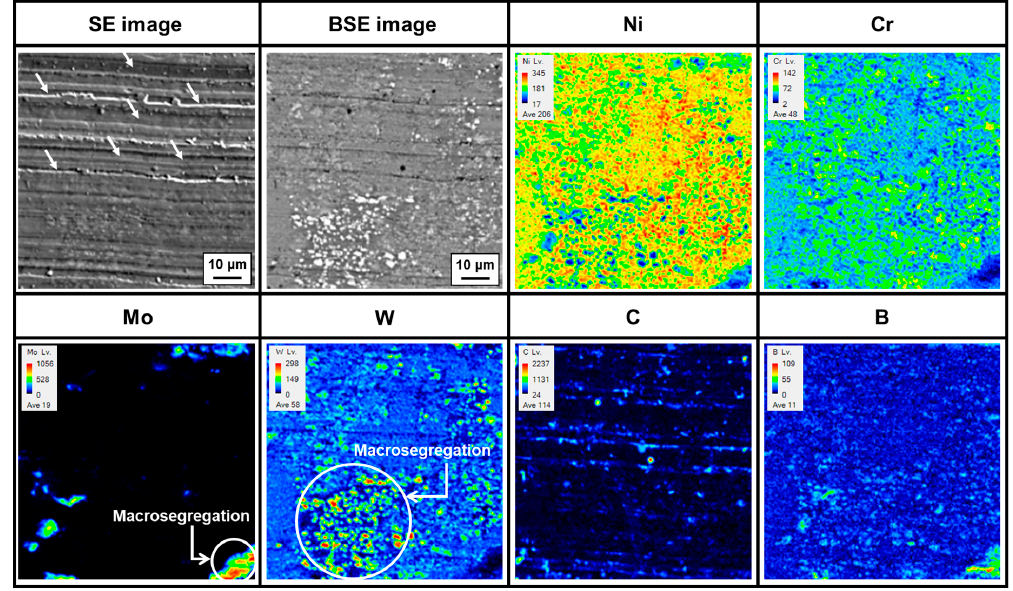
Figure 13. EPMA analysis for worn surface of as-sprayed 1276F coating.